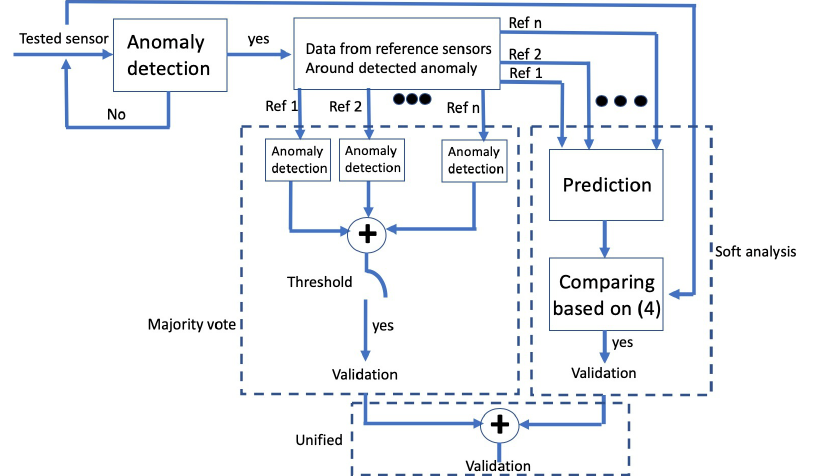
Figure 5. Illustration of the detection verification